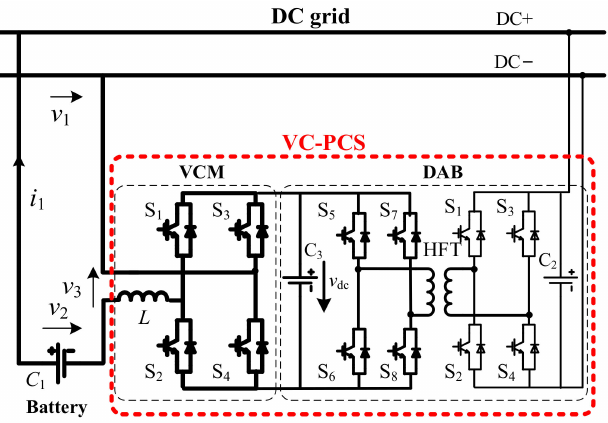
Figure 2. VC-PCS topology.